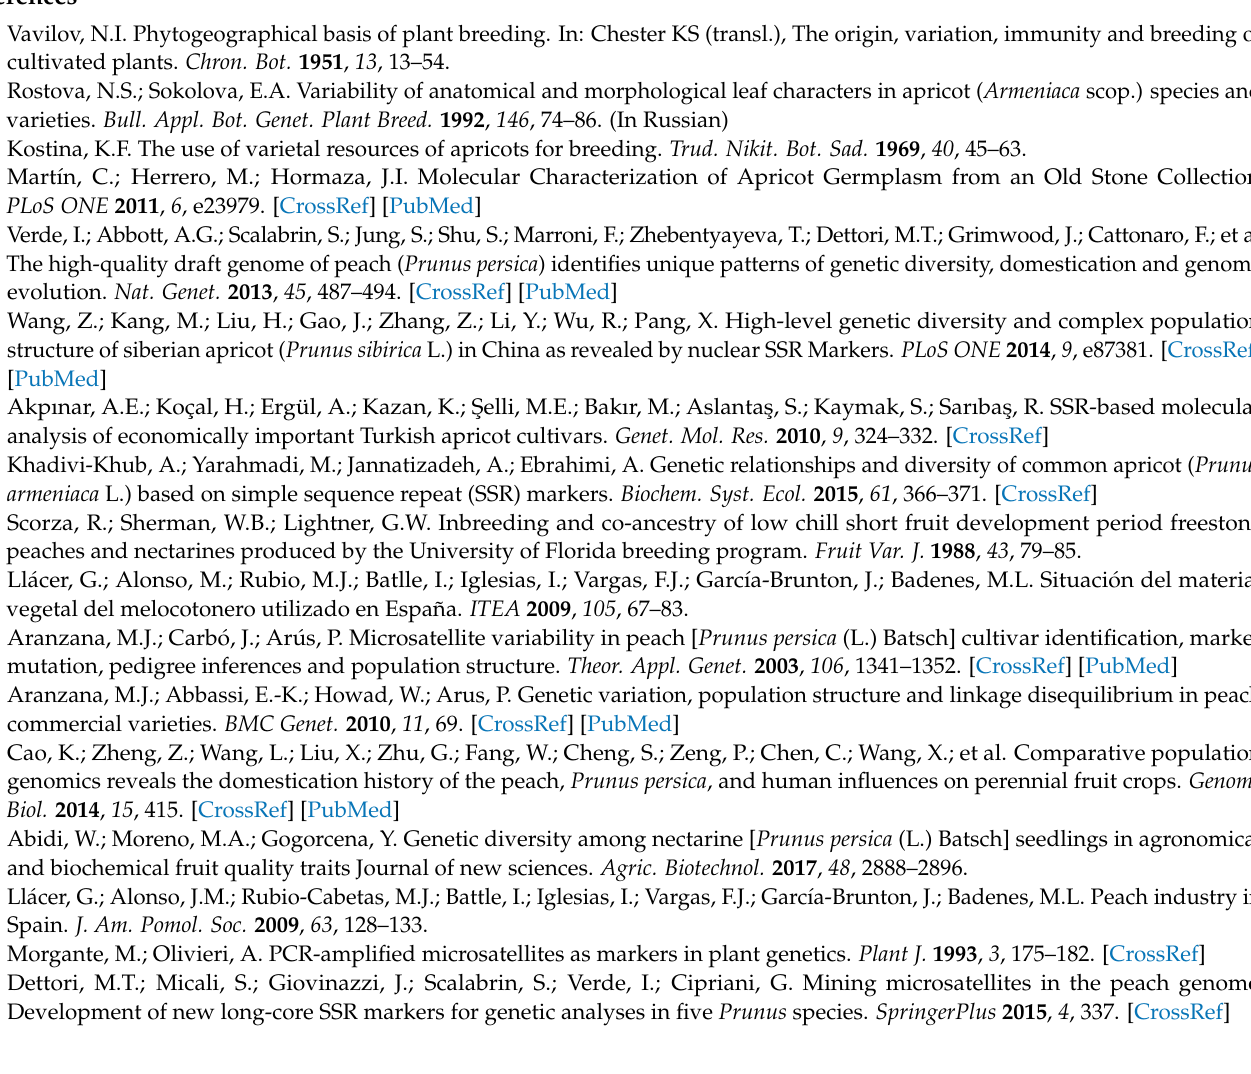
grams of polymorphic microsatelite marker BPPCT-025. Figure S5. Prunus electropherograms of polymorphic microsatelite marker Pchgms-020. Figure S6. Prunus electropherograms of polymorphic microsatelite marker Pchgms-021. Figure S7. Prunus electropherograms of polymorphic microsatelite marker UDP96-001. Figure S8. SSR markers in peach (a-BPPCT038; b-PMS067), apricot (c-pchcm3, d- pchcm10) and nectarine cultivars (e-CPPCT022, CPPCT029, CPPCT030; f-pchcm1, pchcm3, pchcm4); separation on 1.5% agarose gel stained with 0.5 µ g/mL ethidium bromide. The order of the samples is shown in Table